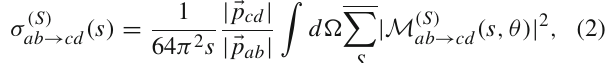
Fig. 1 Total cross section for monopole–antimonopole pair produc- tion q ¯ q → M ¯ M as a function of the center-of-mass energy different values of the monopole mass M . Plots in the top and bottom panels describe spin-zero and spin-half monopoles, respectively